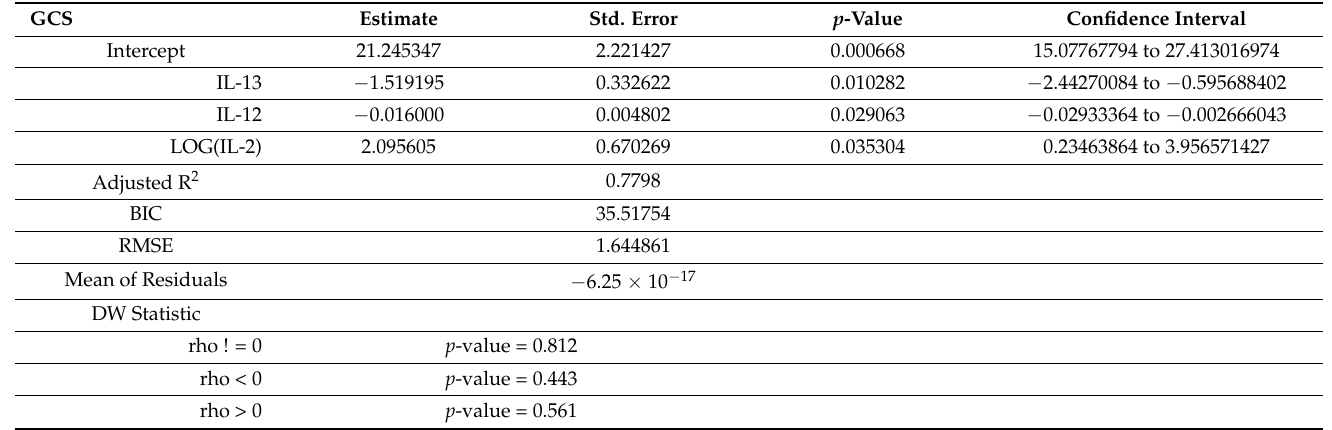
Table 3. Linear Regression Model to predict